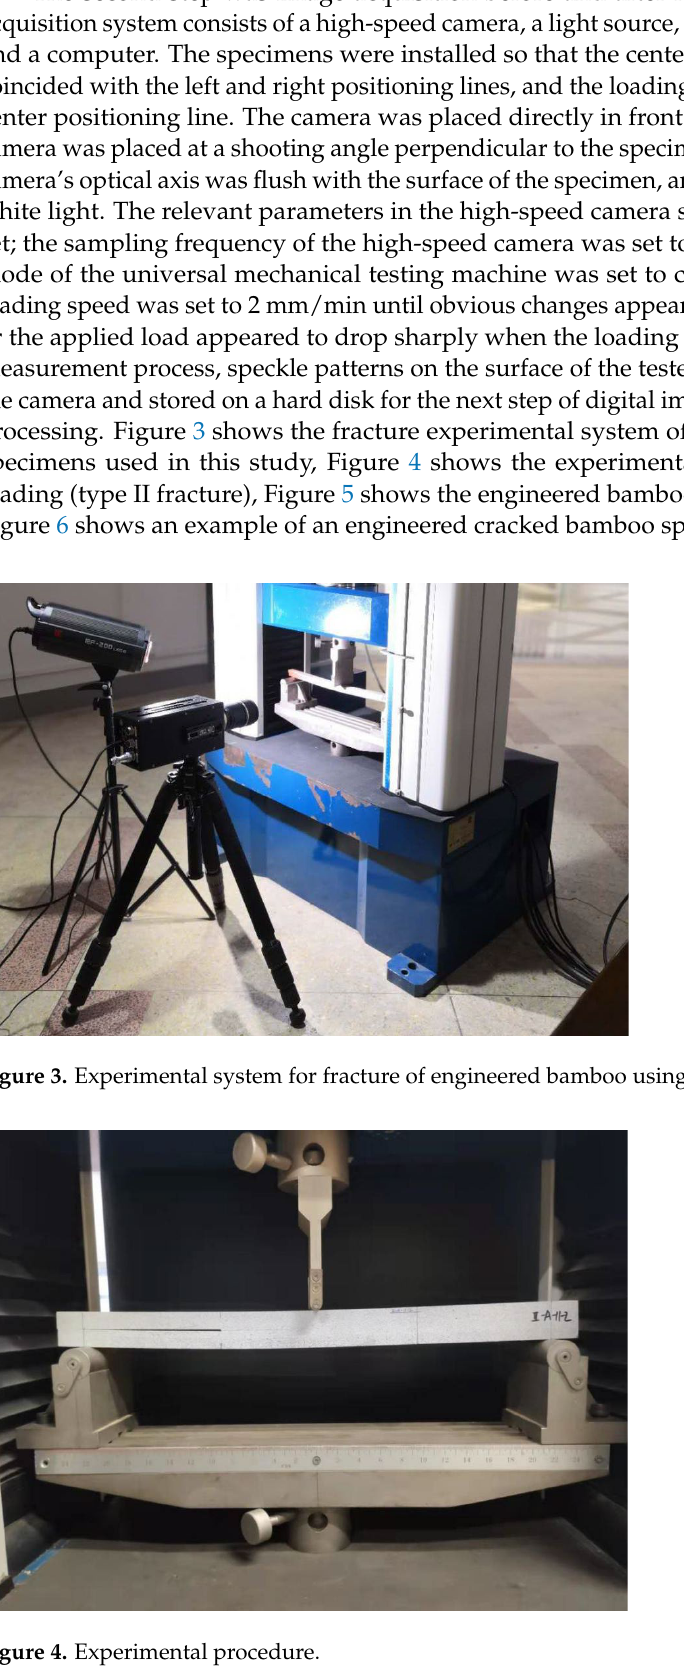
Table 3. Dimensional parameters of engineered-bamboo specimens (unit: mm).